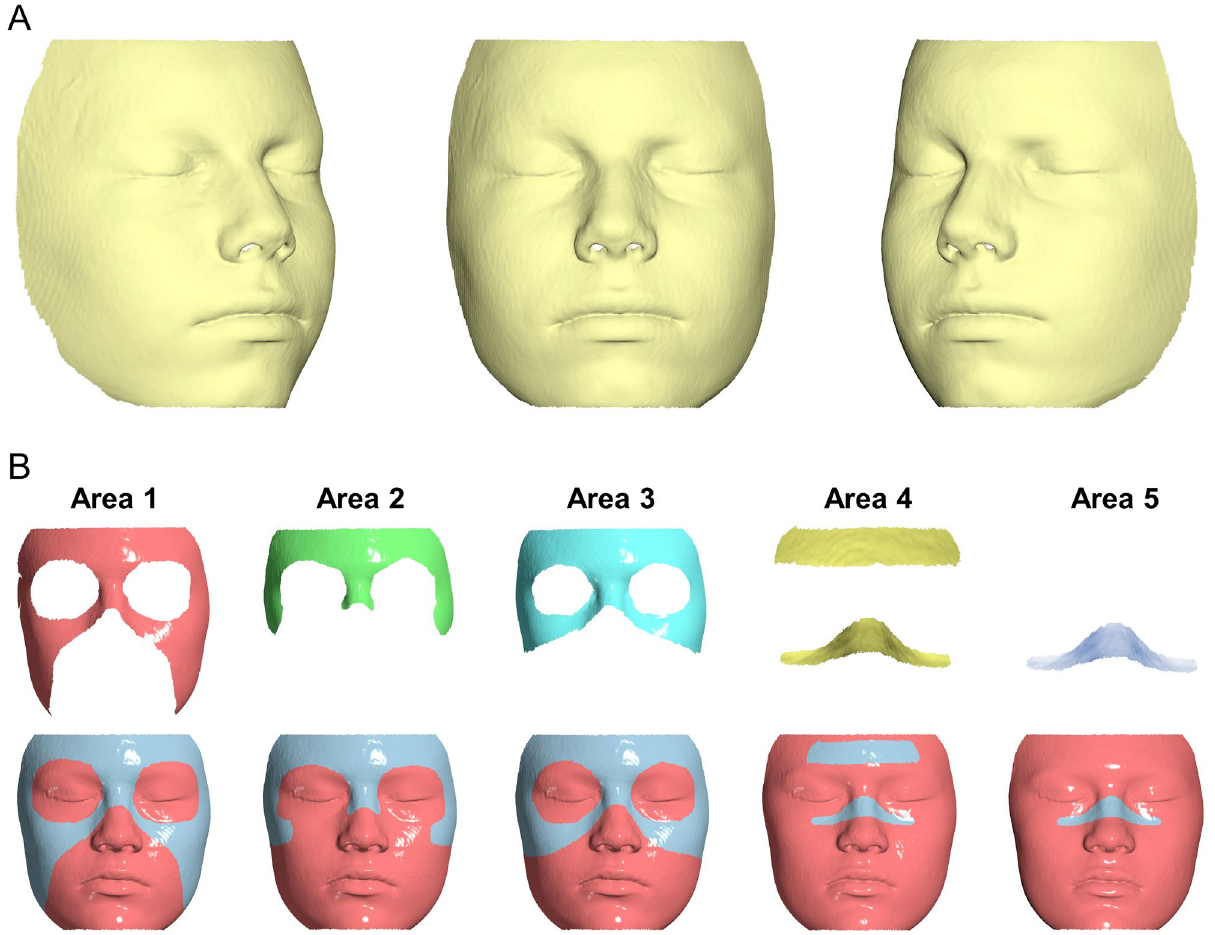
Figure 1. ( A ) Example of a cropped CBCT derived facial surface model that was used in the study. ( B ) Facial surface superimposition reference areas tested in the study. At the last row, the light blue color indicates the selected reference area. All images were generated using Viewbox 4 software (version 4.1.0.1 BETA, http:// www. dhal. com/ viewb oxind ex.